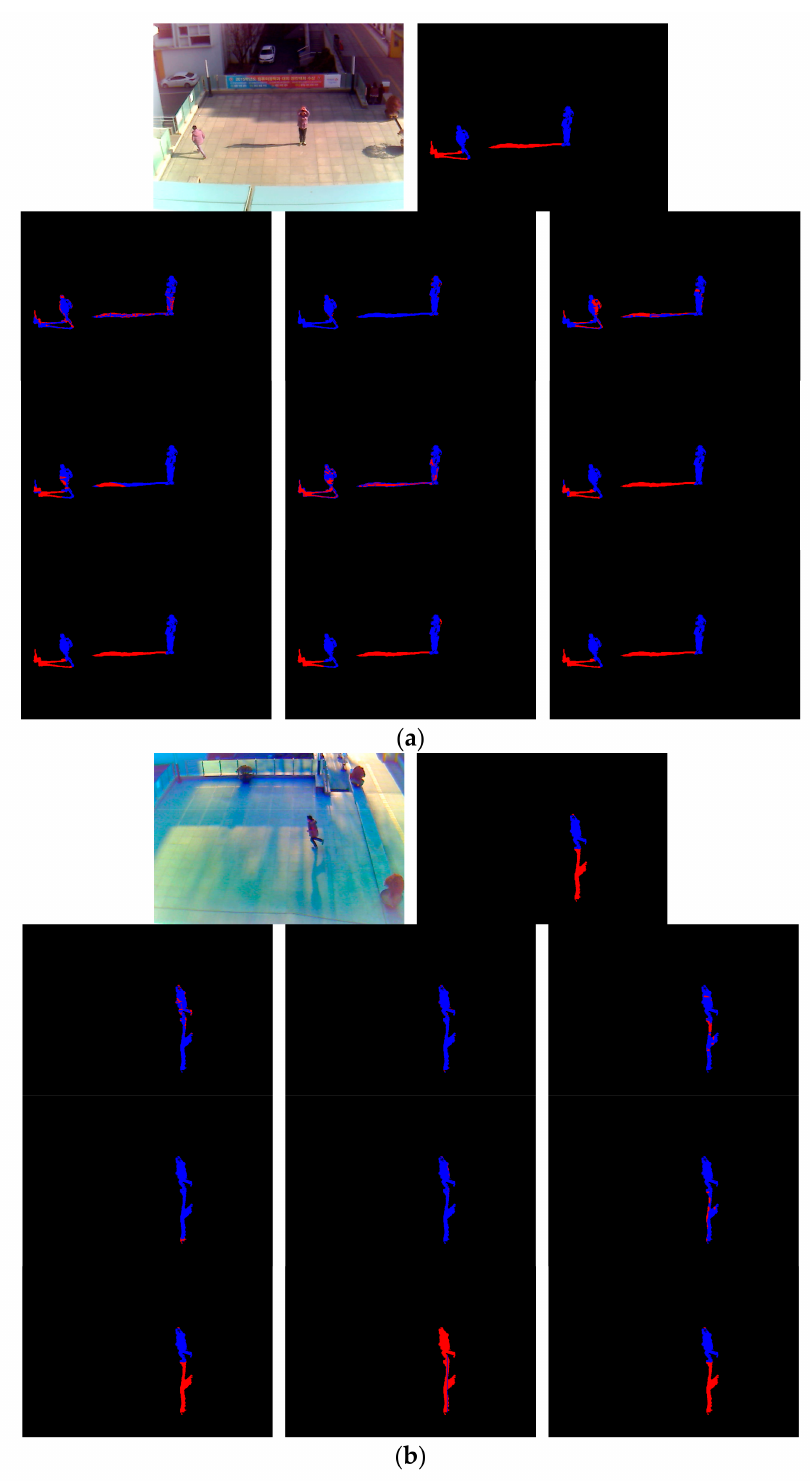
Figure 8. Detection results in experimental images: ( a ) Sub-database 1; ( b ) Sub-database 3. From ( a ) and ( b ), 10 images of each group are, from left to right: input image and ground truth image in the first row; the resultant images of Cucchiara et al. [8], Sanin et al. [15], and Leone et al. [17] in the second row; the resultant images of Hsieh et al. [19], Huang et al. [20], and the Euclidean distance by 4096 features of the first FCL [41] in the third row; and the resultant images of AlexNet [27], Lee et al. [3], and the proposed method in the fourth row. Non-shadow and shadow regions are shown as blue and red colors,